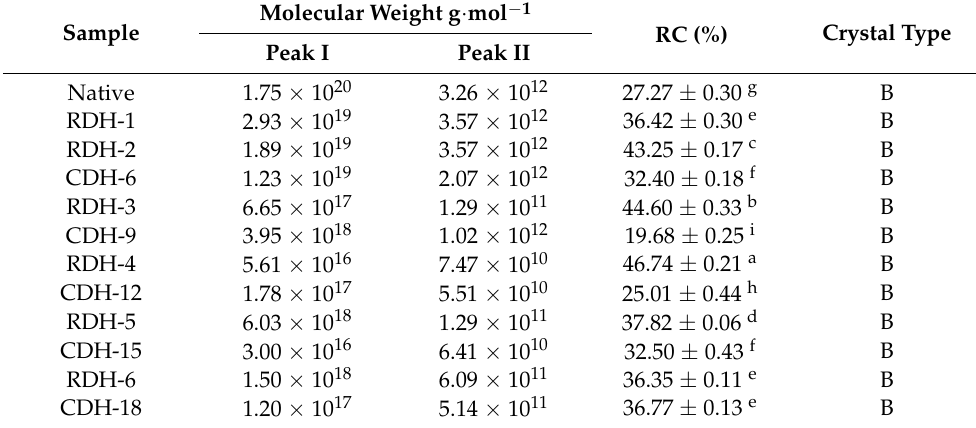
Table 1. Molecular weight and XRD patterns of the native, CDH- and RDH-treated potato starch